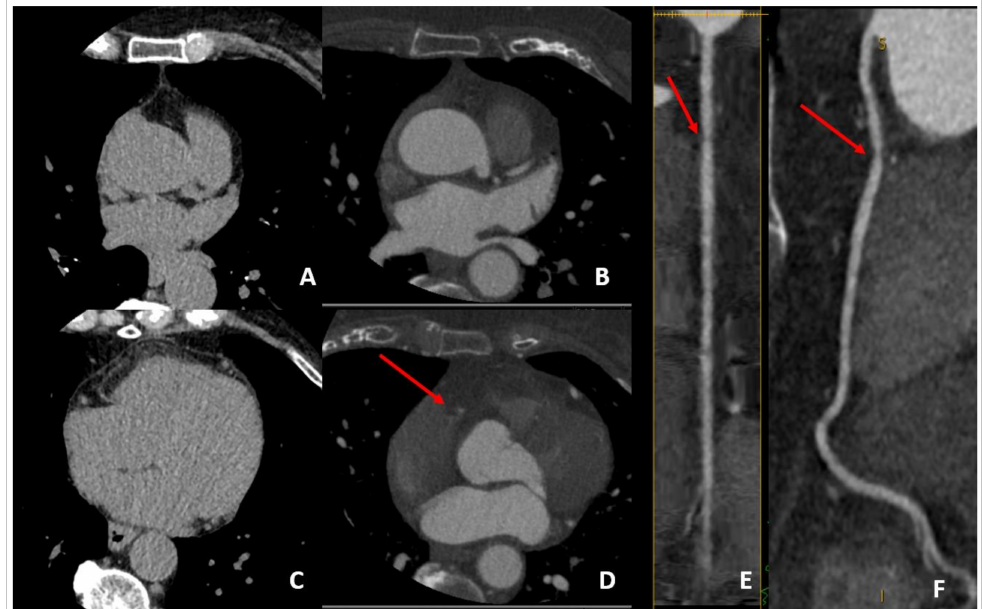
Figure 2. A case example of a middle-aged man with a family history of coronary artery disease (CAD) and noncardiac chest pain who was found to have a CACS value of 0 (panels ( A , B )), but with identification at CCTA of fibro-lipidic plaque on proximal RCA (panels ( C , D ) in axial view). This high risk (positive remodeling and low-attenuation plaque) causes a moderate stenosis (50% to 70% stenosis) that is well evidenced at curved analysis (red arrow on panels ( E , F )). This may merit aggressive cardiovascular risk factor control with preventive therapy in order to reduce the future risk of cardiovascular events that may be underestimated by CACS alone.